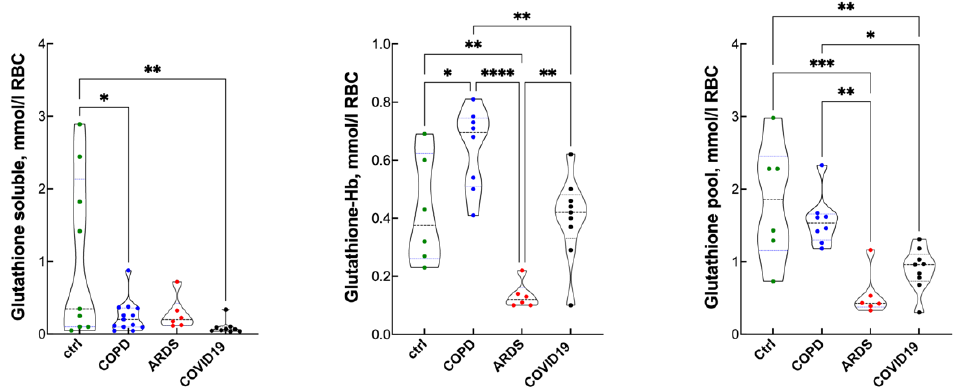
Figure 4. RBC soluble glutathione, glutathionyl-Hb and total RBC glutathione pool in controls, COPD, ARDS and COVID-19 (violin plots). * p < 0.05; ** p < 0.01; *** p < 0.005; **** p < 0.0001 at the Tukey’s post-test.